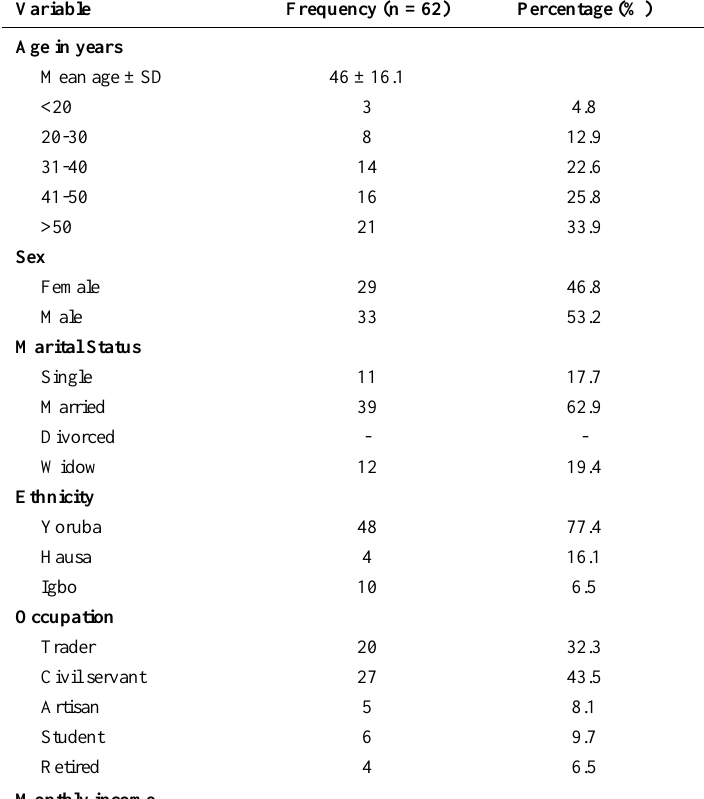
Table 1. Socio-Demographic Characteristics of